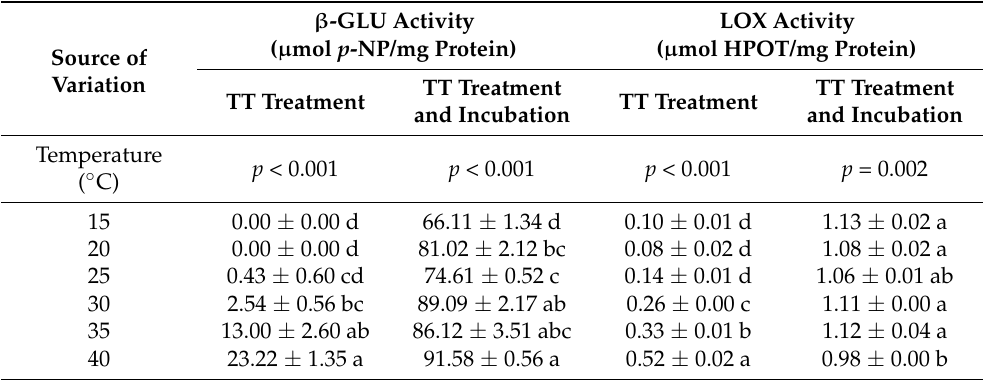
Table 1. Enzyme activity of thermally treated (TT) β -glucosidase ( β -GLU) and lipoxygenase (LOX) and after the additional incubation of the model systems at 25 ◦ C for 30